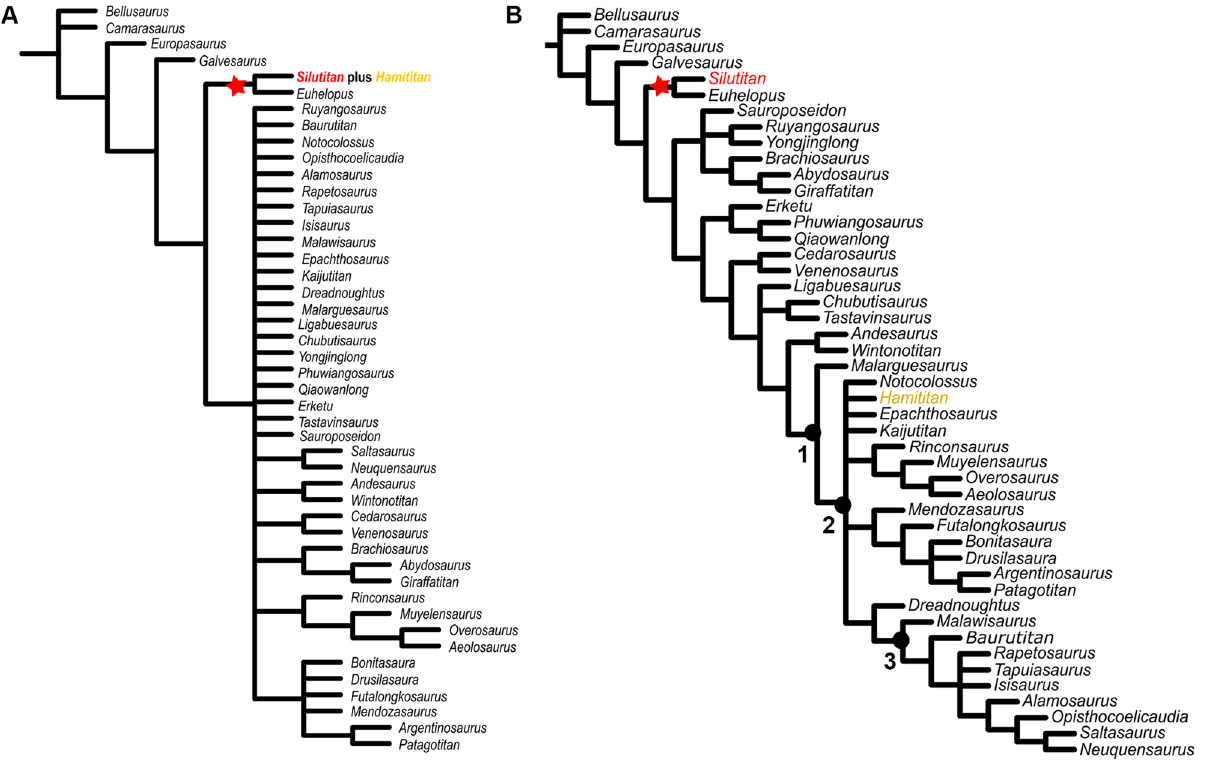
Figure 6. Strict consensus cladogram based on Filippi et al. dataset 67 : ( A ) Silutitan sinensis and Hamititan xinjiangensis scored as a single taxon; and ( B ) Silutitan sinensis and Hamititan xinjiangensis scored as two separated taxa. Nodes numbers indicate the clades retrieved: 1. Titanosauria, 2. Colossosauria, and 3. Lithostrotia. Silutitan sinensis is highlighted in red and Hamititan xinjiangensis , in